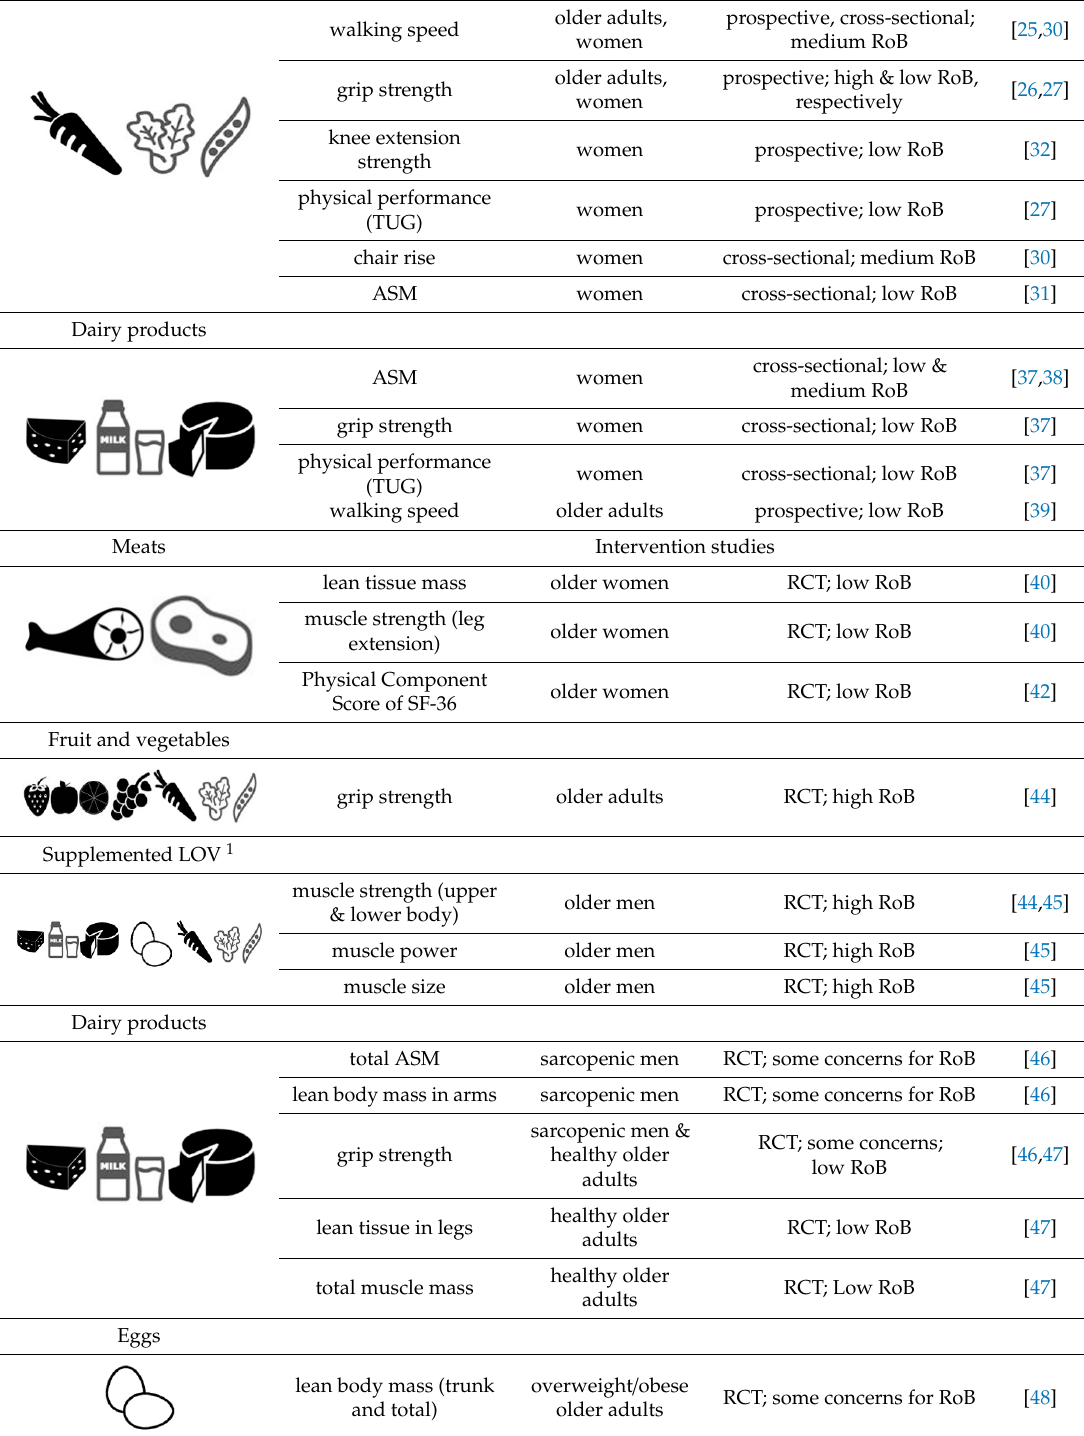
Table 3. Myoprotective whole foods: summary of evidence from observational and intervention studies